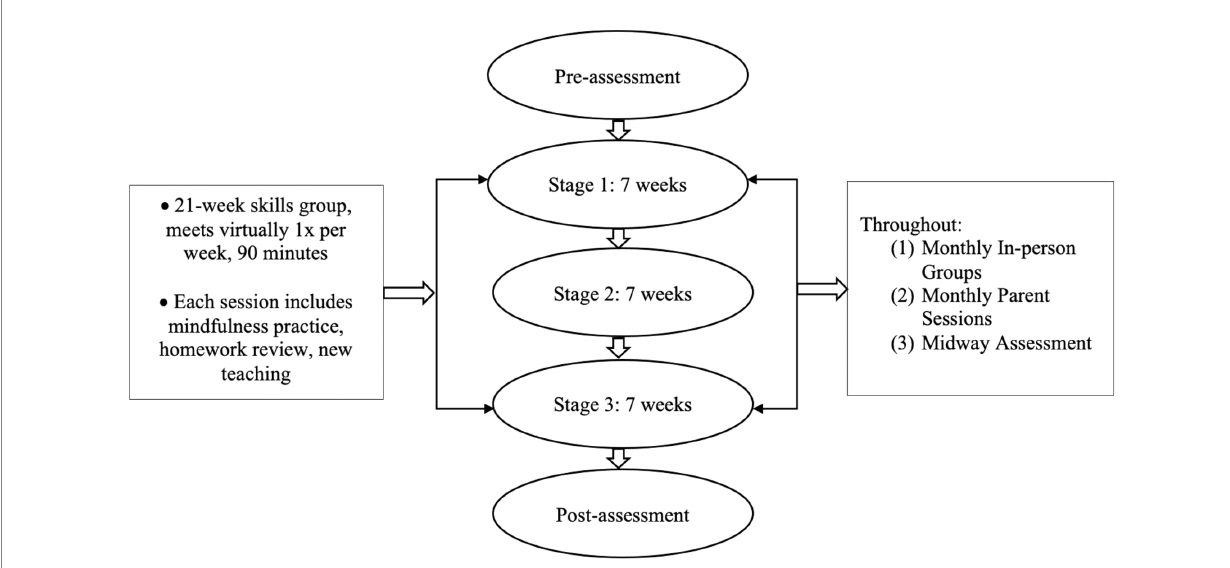
FIGURE 2 Schematic depicting SPACE group details. Stage 1 goal = Build Awareness; Reduce Distress, Stage 2 goal = Increase Self-Connectedness, Stage 3 goal = Enhance Social Connectedness.